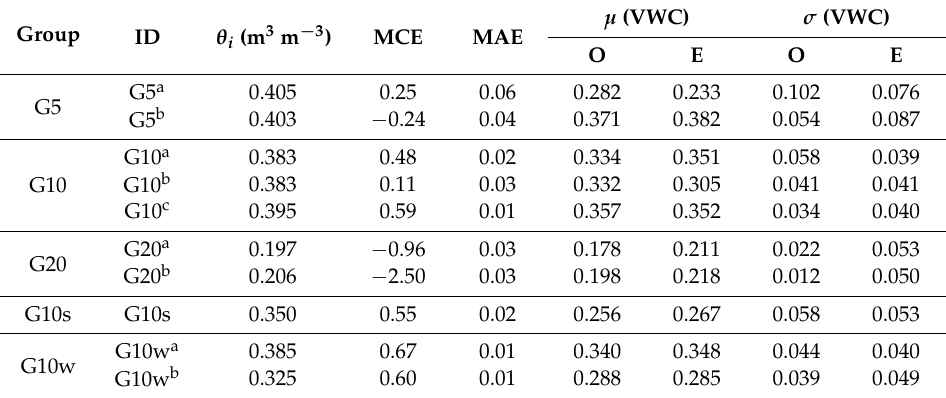
Table 5. MCE, MAE, mean ( µ ) and standard deviation ( σ ) from observed (O) and estimated (E) volumetric water content (VWC) during the rainy season